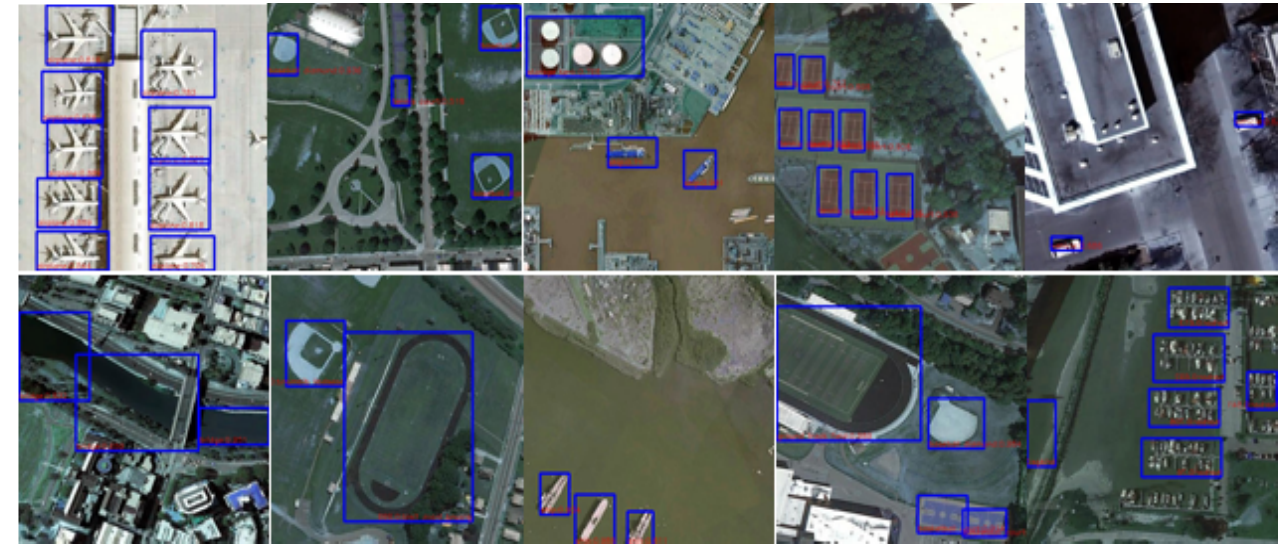
Figure 8. Example results on the NWPU VHR-10 test set for each